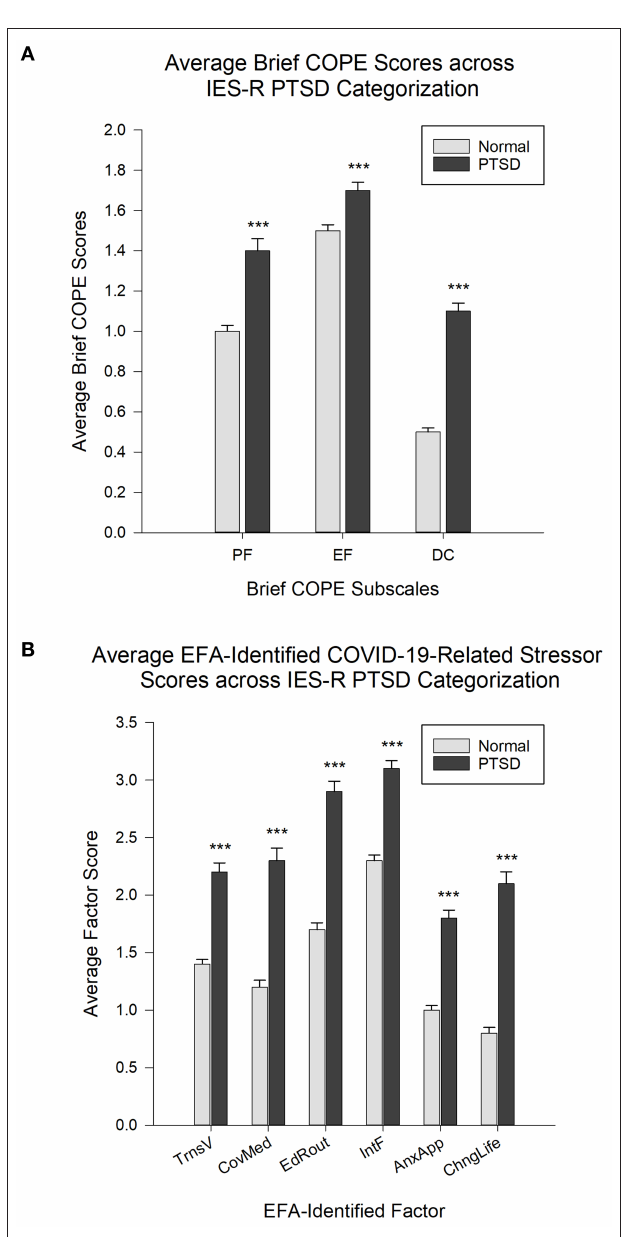
FIGURE 4 | (A) Average Brief COPE scores for each subscale across IES-R categorization of scores falling within the normal range ( < 24, Normal) and those falling within the range of clinical concern for PTSD ( ≥ 24, PTSD). EF, emotion-focused coping; PF, problem-focused coping; DC, dysfunctional coping. N = 582; Normal : n = 426; PTSD : n = 156. (B) Average factor scores, with higher scores interpreted as higher likelihood of perceiving the stressors as more stressful, across IES-R categorization of Normal ( < 24, Normal) and of clinical concern for PTSD ( ≥ 24, PTSD). N = 608; Normal : n = 449; PTSD : n = 159. *** p < 0.001 relative to the Normal group. Data is expressed as Mean ± SEM.